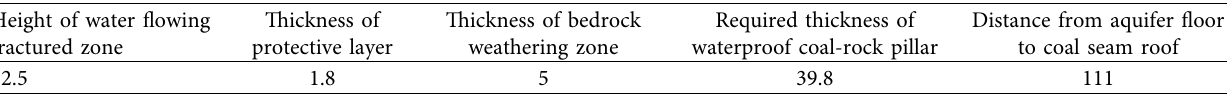
Figure 16: Height variation curve of water flowing fractured zone height with accumulative layered backfill thickness. Table 8: Calculation of the waterproof coal-rock pillar, unit: